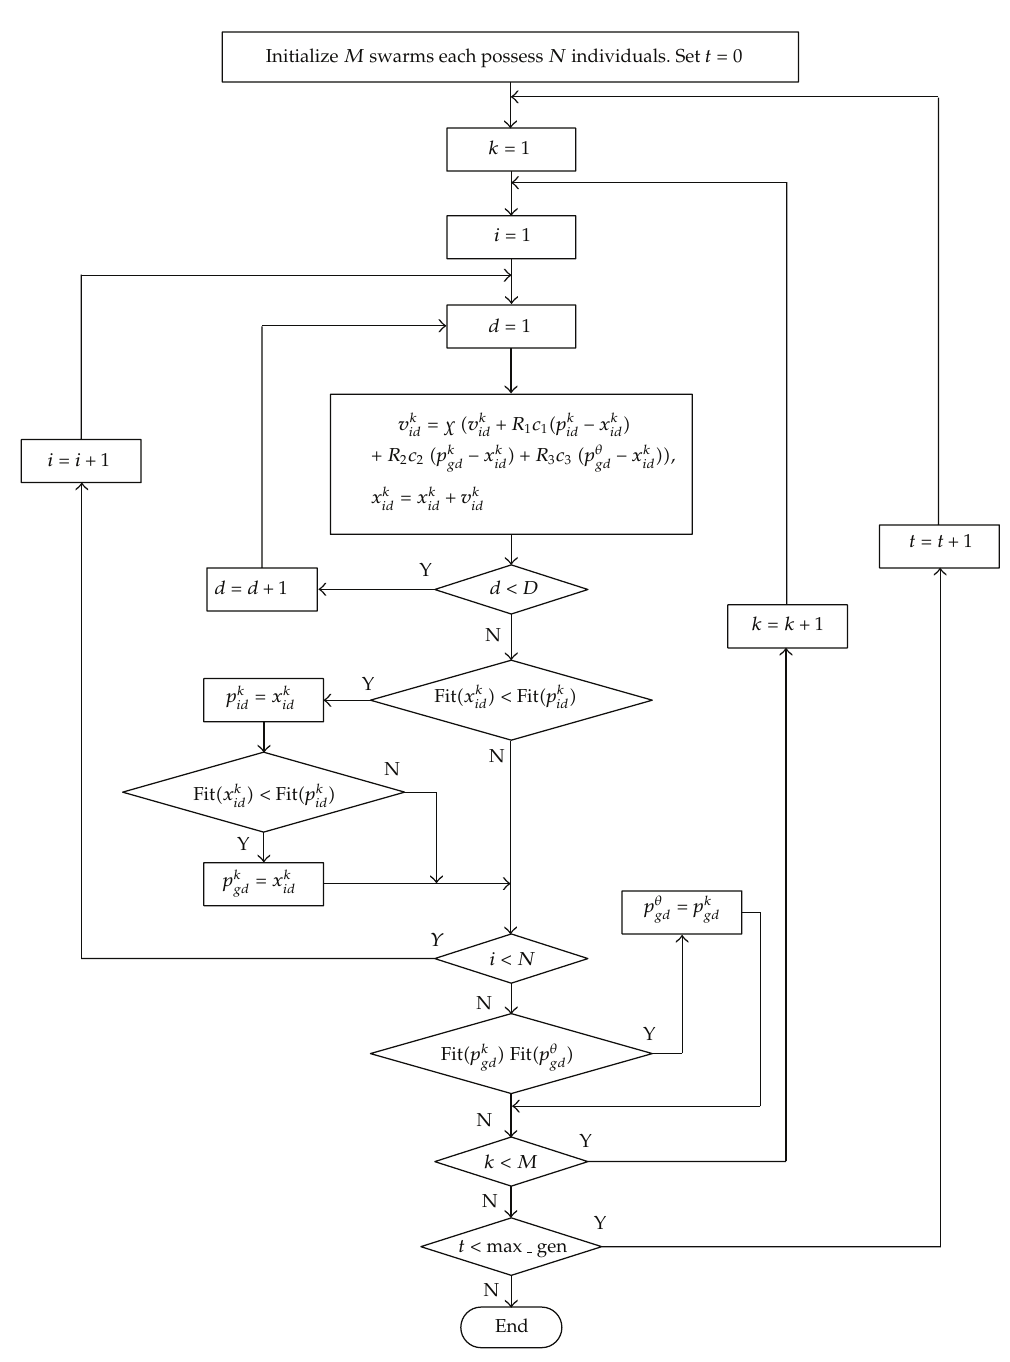
Figure 2: The flowchart of the PS 2 O